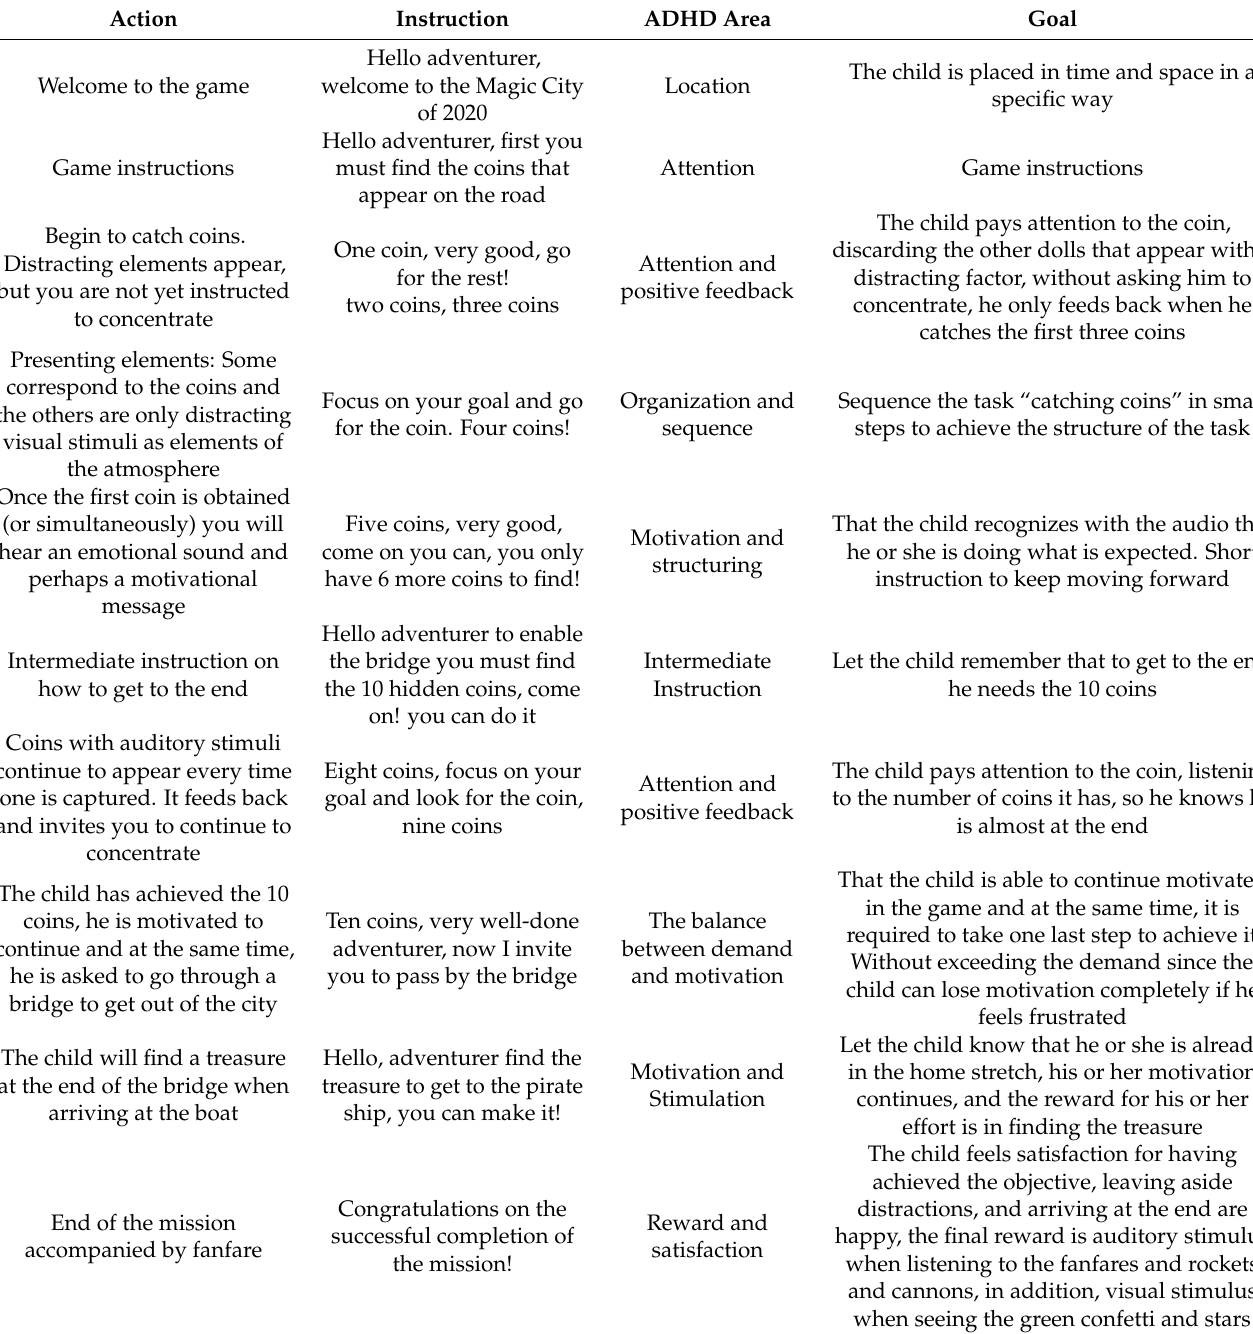
Table 4. Extended instructional design for a new virtual environment called